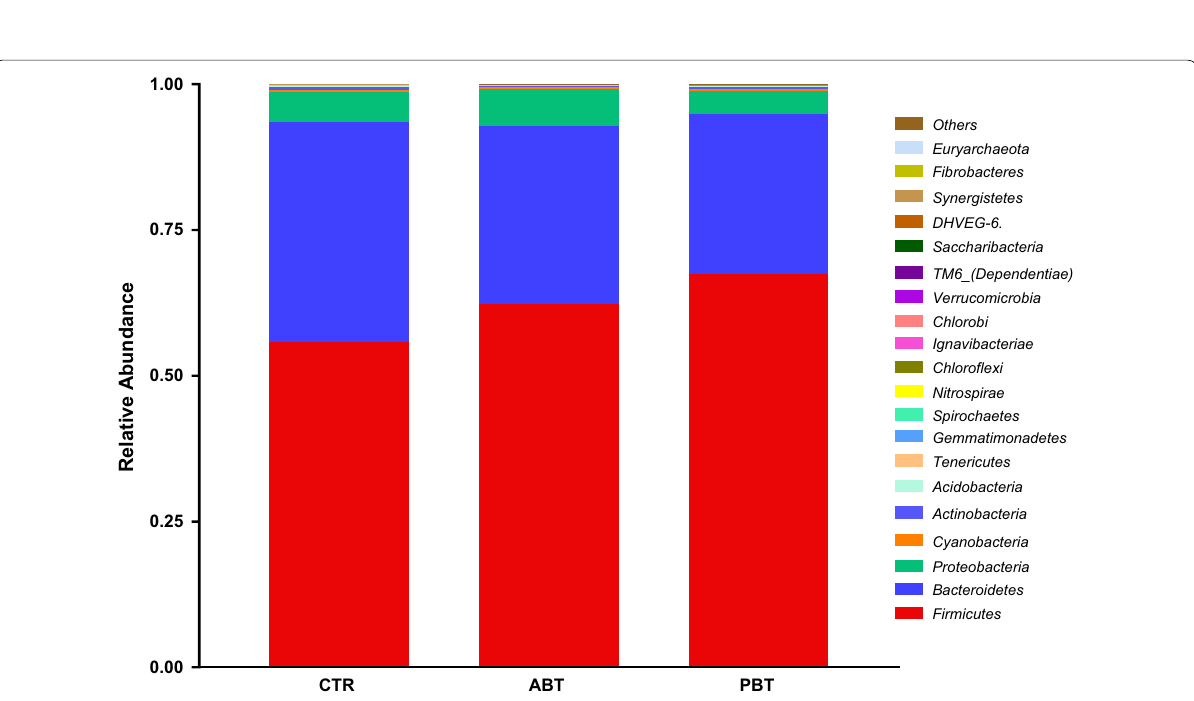
Fig. 3 Effects of dietary B. subtilis supplementation on colonic microbiota composition at phylum level with the relative abundance within the top 20 of